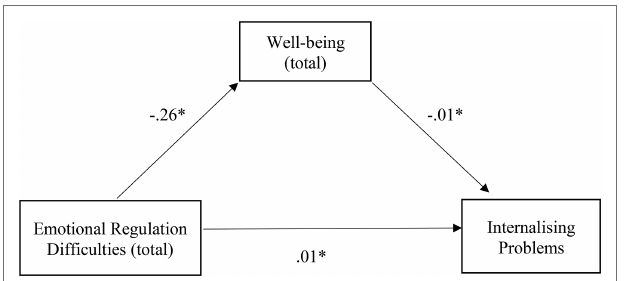
FIGURE 4 | Illustration of the direct effects of emotional regulation difficulties for internalizing problems through the mediator well-being in clinical group. The represented coefficients are standardized. Total effect ( β = 0.01, p < 0.05). * p < 0.05.